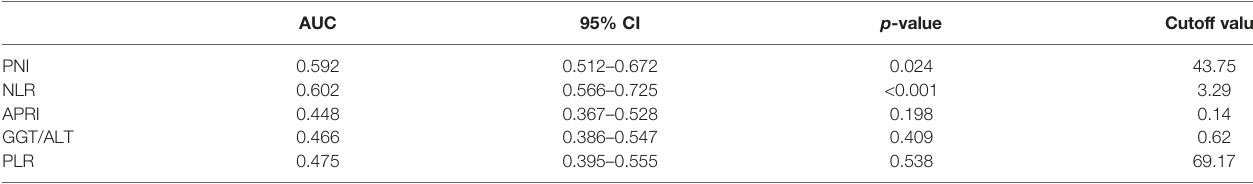
TABLE 1 | Comparison of the AUC between in fl ammation-based prognostic scores. AUC 95% CI p -value